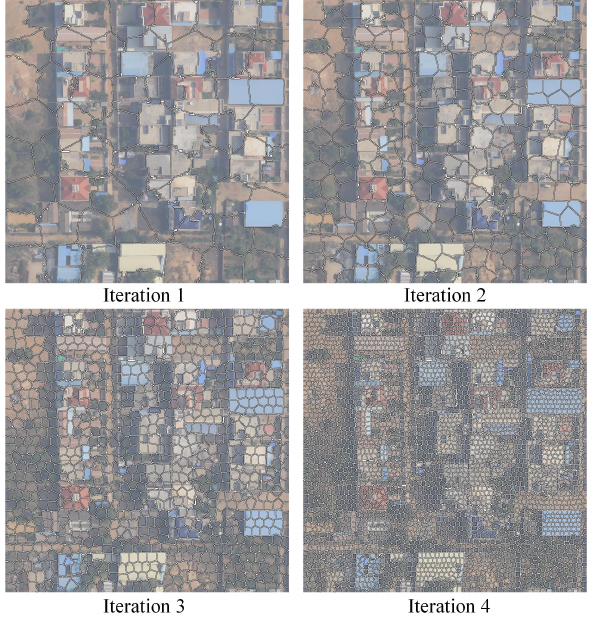
Figure 2. Multiscale SLIC superpixels in different